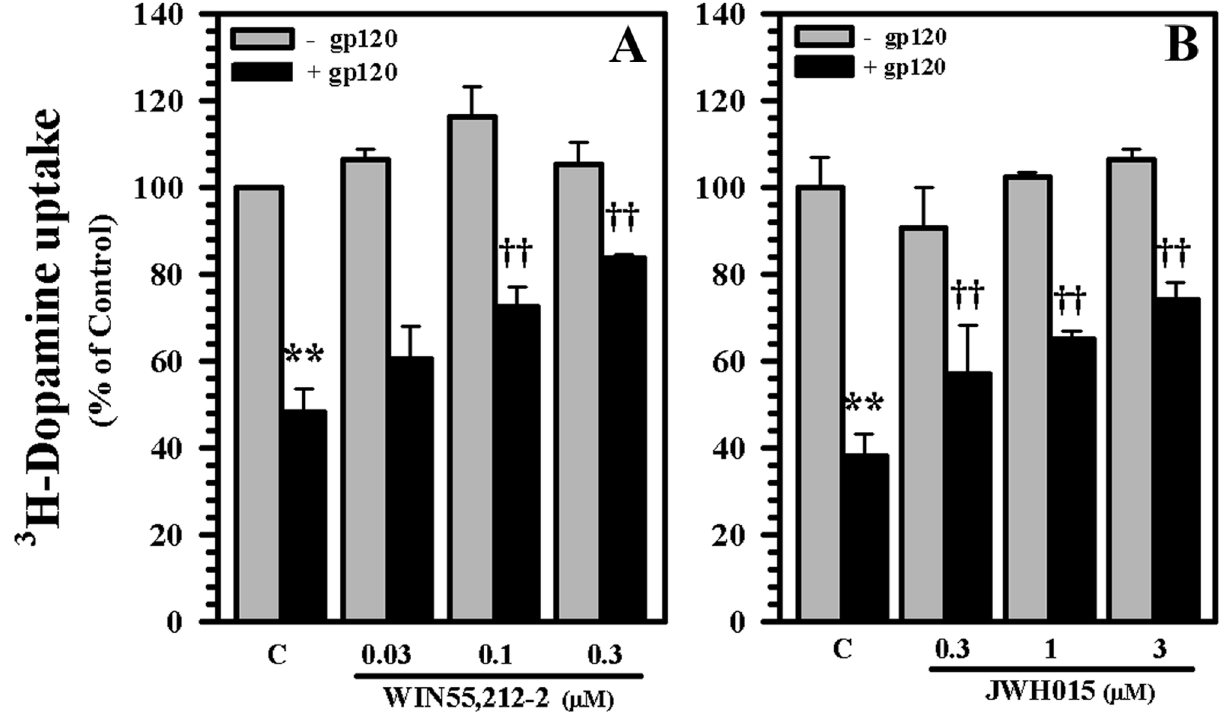
Figure 2. Blockade of gp120-induced suppression of DAT activity. Human mesencephalic neuronal/glial cultures were untreated (C) or pretreated with A ) WIN55,212-2 or B ) JWH015 at the stated concentrations for 3h prior to gp120 (10 nM) treatment for 5 days followed by 3 H-DA addition for 10 min as a measurement of 3 H-DA uptake for DAT activity. Data are mean ± SEM of triplicates of 3-4 separate experiments using different brain tissue specimens. **p<0.01 vs. control; ††p<0.01 vs. gp120. doi: